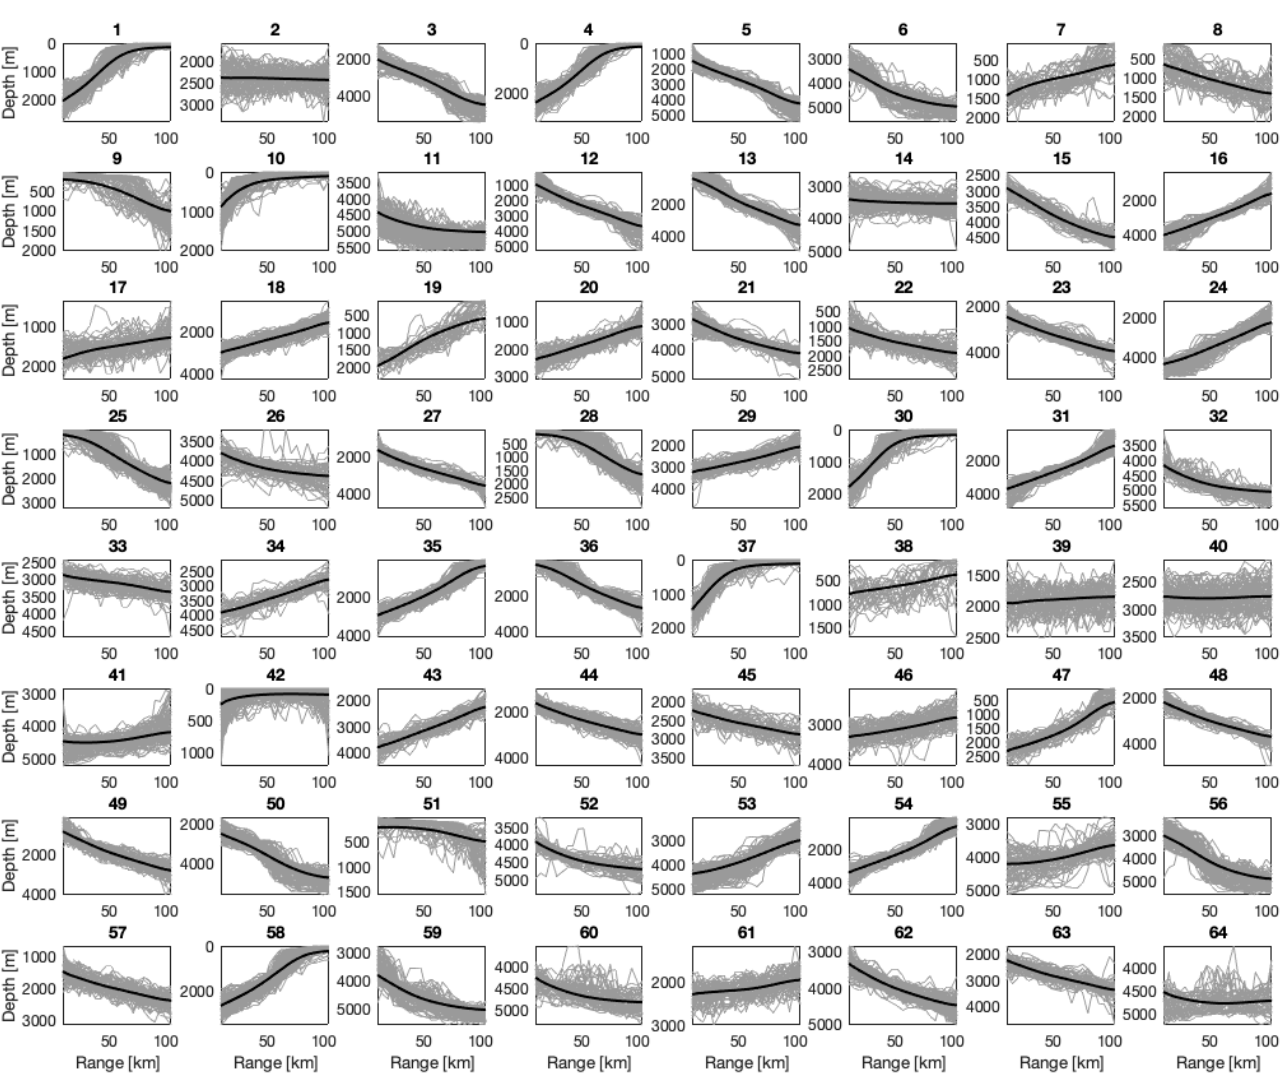
Figure 3. Graphs of all 98,532 source-receiver transects of Zone 16 plotted by cluster (grey), with centroid bathymetries shown in black. X-axes are range (km) and Y-axes are depth below the sea surface (m). Note the changing Y-ranges.